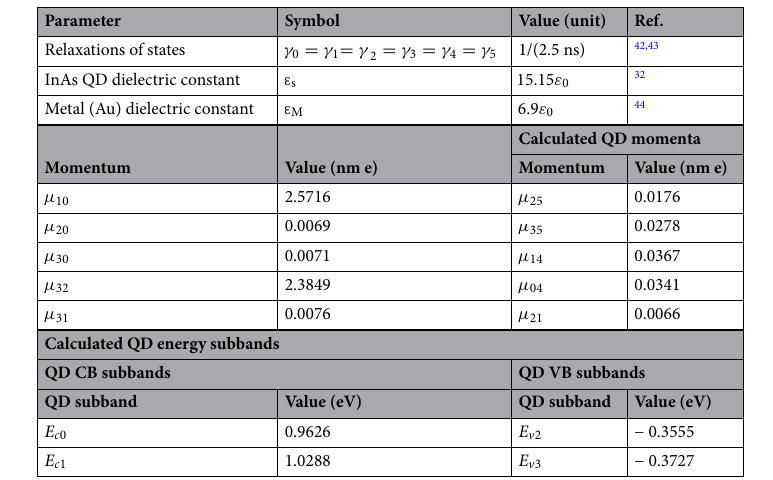
Table 1. The parameters used in the